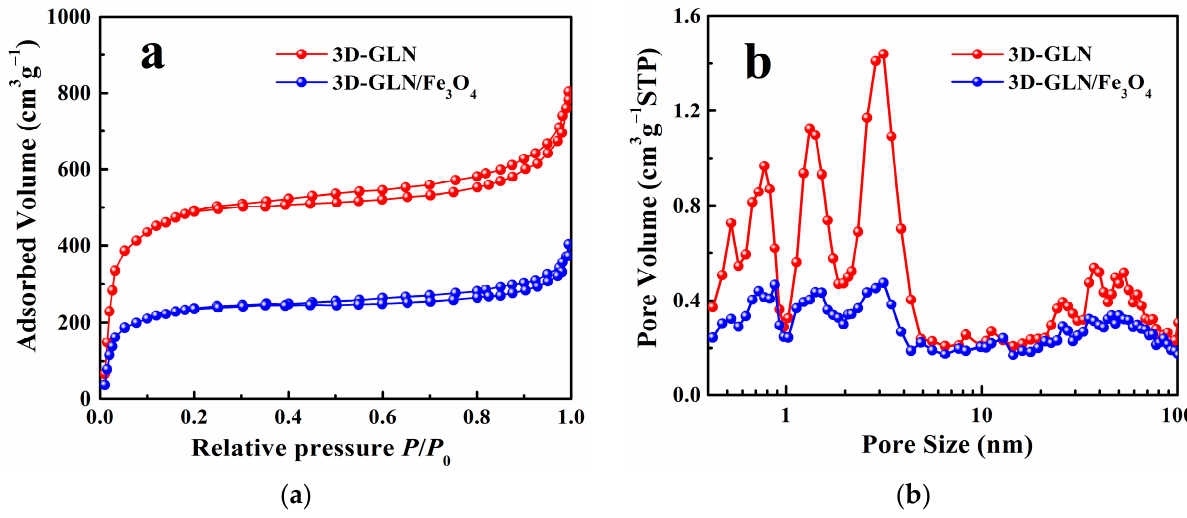
Figure 4. Nitrogen adsorption/desorption isotherms ( a ), the pore size distributions of 3D-GLN and 3D-GLN/Fe 3 O 4 ( b ).